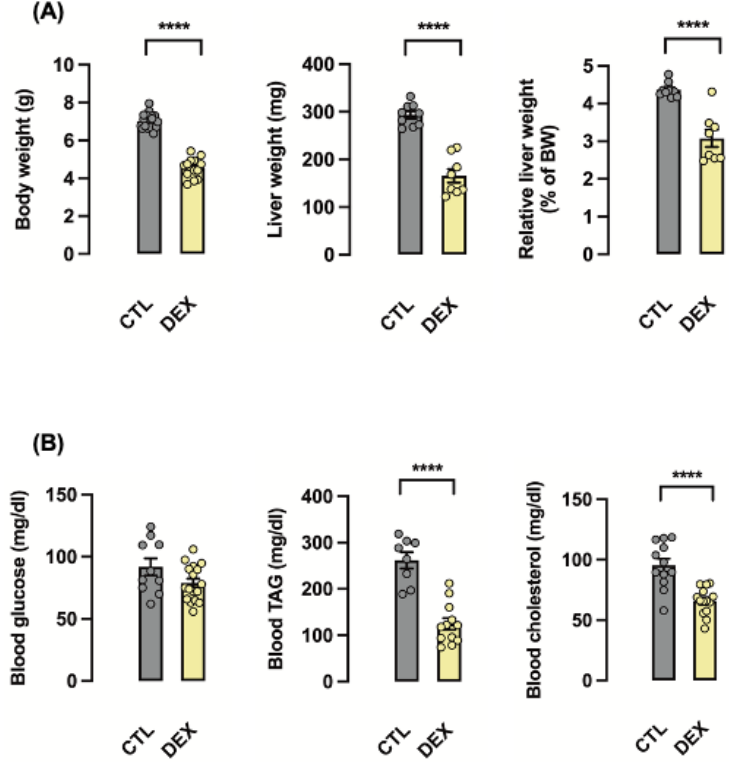
Figure 1. Maternal dexamethasone treatment induced hepatic growth restriction and altered bio- chemical parameters in the offspring in early life. Body mass, liver mass and relative liver mass of rats born to DEX-treated mothers (DEX) and untreated mothers (CTL) were assessed at the first day of life ( A ). Blood glucose, triacylglycerol (TAG) and total cholesterol were also assessed at the first day of life ( B ). Data are presented as the mean ± SEM; **** p < 0.0001 vs. CTL. In ( A ), offspring’s total body mass (CTL: n = 19; DEX: n = 14); total liver mass and relative liver mass (% of total body mass) (CTL: n = 10; DEX: n = 8). In ( B ), blood glucose (CTL: n = 10; DEX: n = 17), TAG (CTL: n = 8; DEX: n = 12) and total cholesterol (CTL: n = 12; DEX: n = 14).